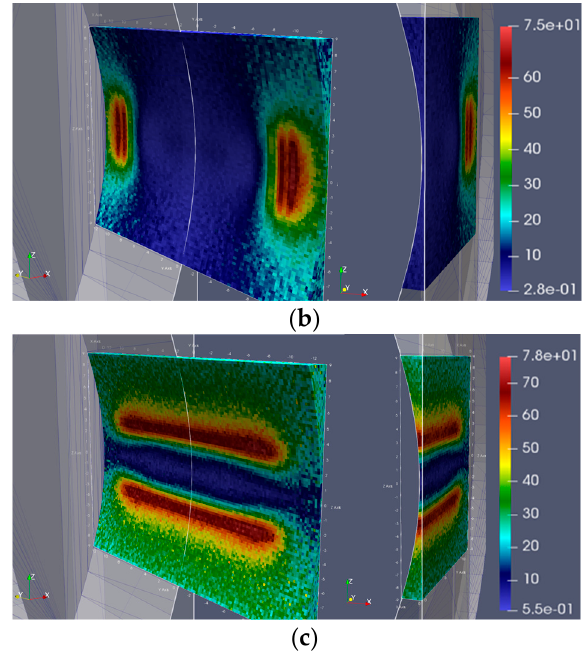
Figure 8. DPA gradient (%/cm) along X, Y, and Z directions. ( a ) X, ( b ) Y, and ( c ) Z.